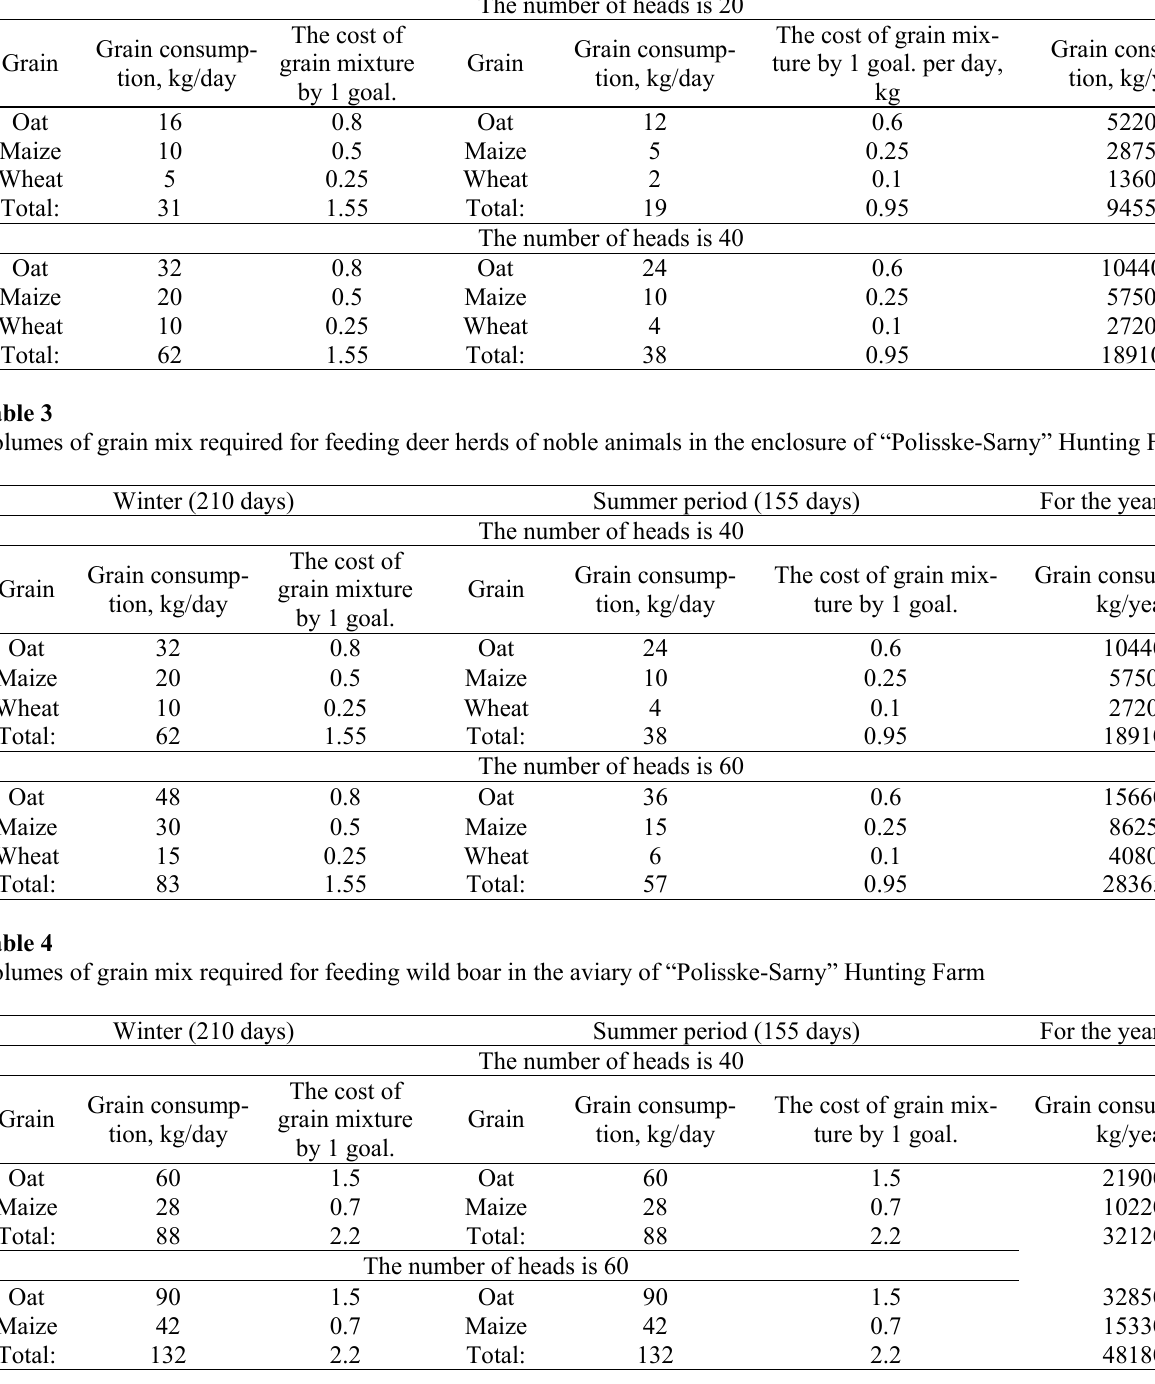
Volumes of grain mix necessary for feeding the livestock of fallow deer in the enclosure of “Polisske-Sarny” Hunting Farm Winter (210 days)